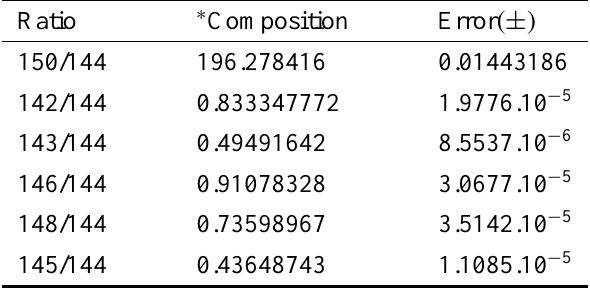
Isotopic Ratios for Nd in mixed Spike, calibrated against with the Blankwash-Tech and BCR-1 rock standards Ratio